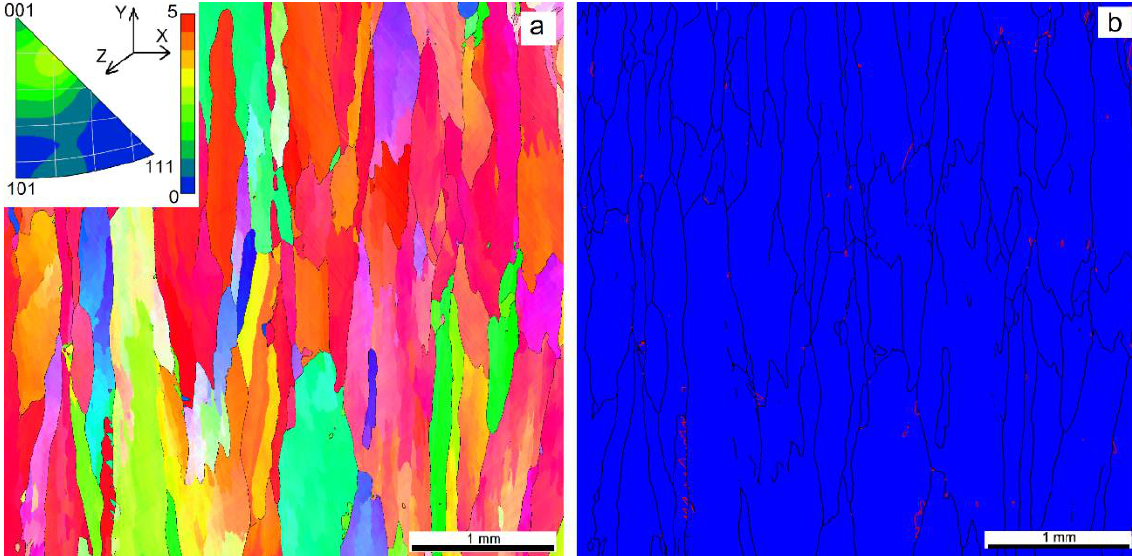
Figure 9. EBSD grain orientation distribution ( a ) and grain boundary types ( b ) in a cross section of the Cu-7.5wt.%Al wall obtained at heat input of 0.3 kJ/mm.